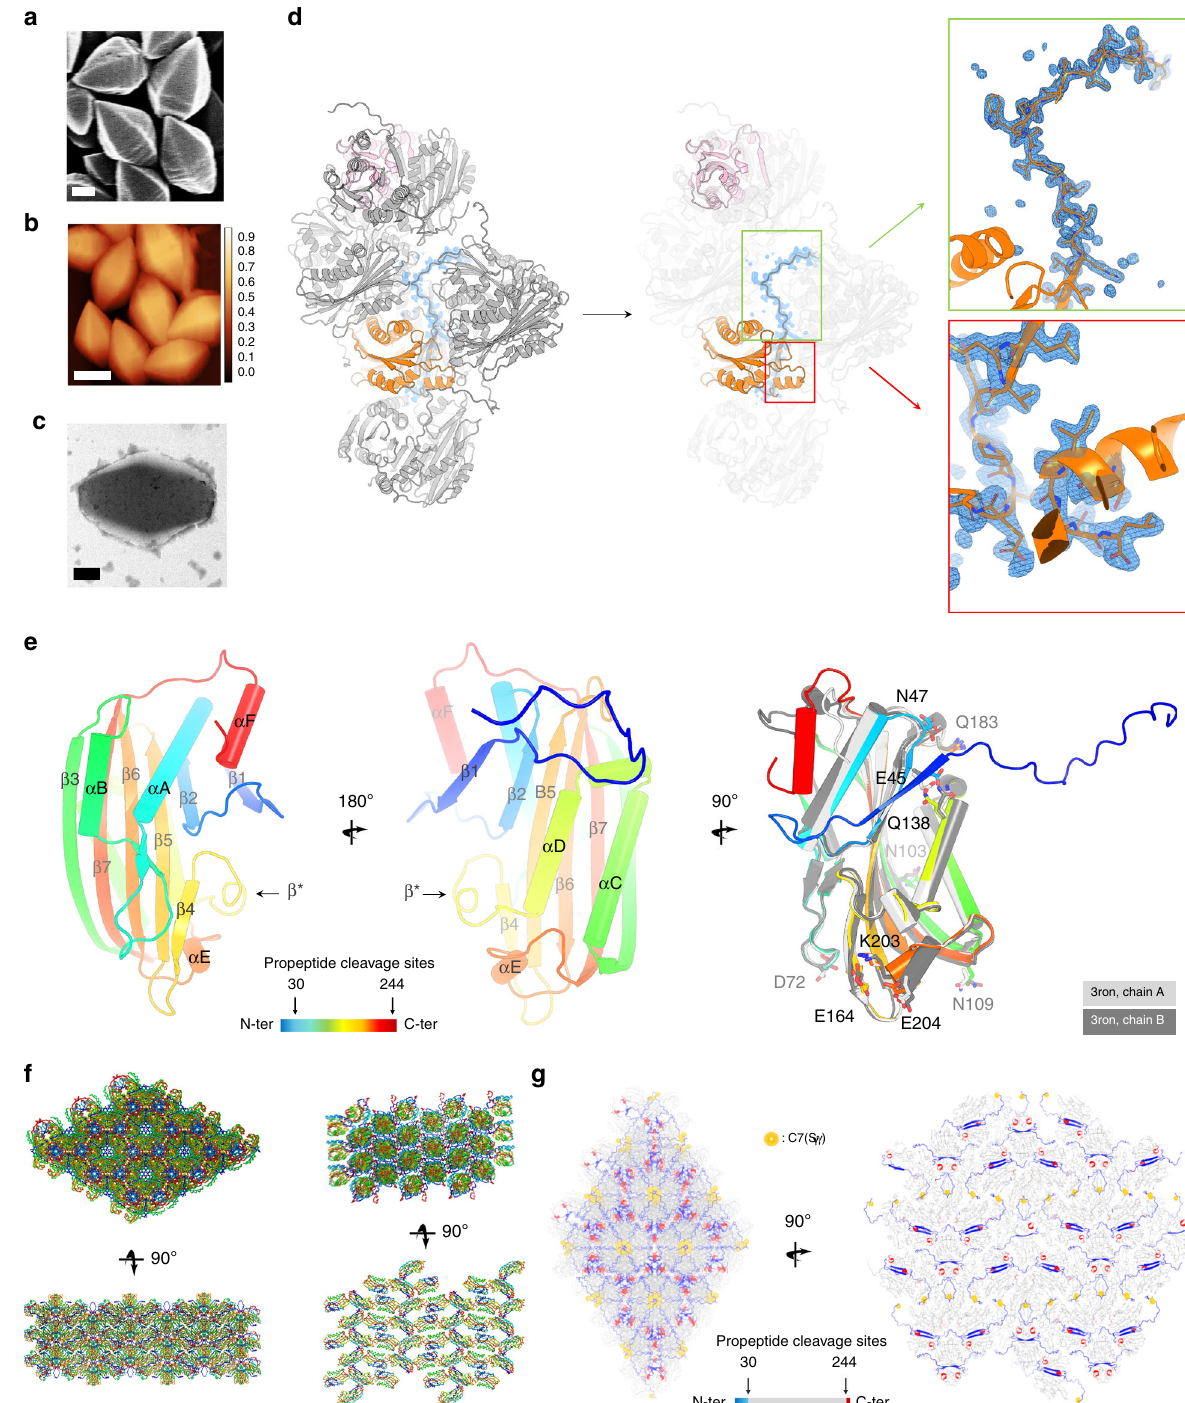
Fig. 1 SFX on in vivo-grown crystals enables determination of the Cyt1Aa protoxin structure. a – c Cyt1Aa sub-micron-sized crystals were grown in vivo by recombinant expression in Bti -4Q7, and their quality assessed by scanning electron microscopy (SEM; a scale bar = 200 nm), atomic force microscopy (AFM; b scale bar = 500 nm) and transmission electron microscopy (TEM; c scale bar = 200 nm). d Electron density was visible for the propeptides in the initial 2Fo-Fc electron density map displayed at 1 σ . The N-terminal propeptide establishes contact with four symmetry-related molecules. e Tertiary structure of Cyt1Aa. In the right panel, the two chains constitutive of the asymmetric unit of the activated toxin ( “ 3ron [10.2210/pdb3RON/pdb] ” ) are overlaid on the protoxin structure, with residues displaying different side chain conformations shown as sticks. Secondary structure information is overlaid on the models. f Packing in the natural protoxin crystals grown in vivo (left) and in the crystals of the activated toxin grown in vitro (right). g The N-terminal and C-terminal propeptides scaffold the natural